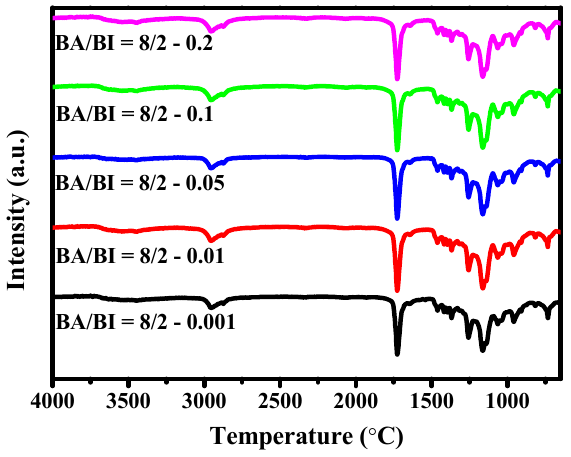
Figure 14. FT-IR spectra of the PBABI copolyesters with different concentrations of EDTA.